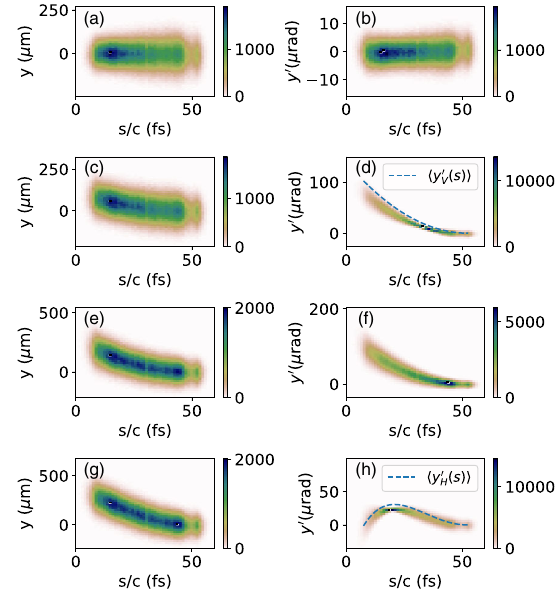
FIG. 4. With the dechirper setup d x ¼ d y ¼ 350 μ m, y − s and y 0 − s distributions of the bunch at (a),(b) the entrance of the first dechirper, (c),(d) the end of the first dechirper, (e),(f) the entrance of the second dechirper, and (g),(h) the end of the second dechirper. The center of the beam line is located at x ¼ y ¼ 0 . The head of the beam is on the right. Notice that the bunch ¯ Φ FIG. 3. The averaged mismatching factor in the lasing longitudinal coordinate on the x axis is shown in femtoseconds. area of the bunch. Variables d x and d y are distances from the Dashed lines in (d) and (h) show vertical angle offsets at the end of the vertical and the horizontal dechirper given by Eqs. (8) center of the bunch to jaws in the horizontal and vertical and (9), dechirpers, respectively.